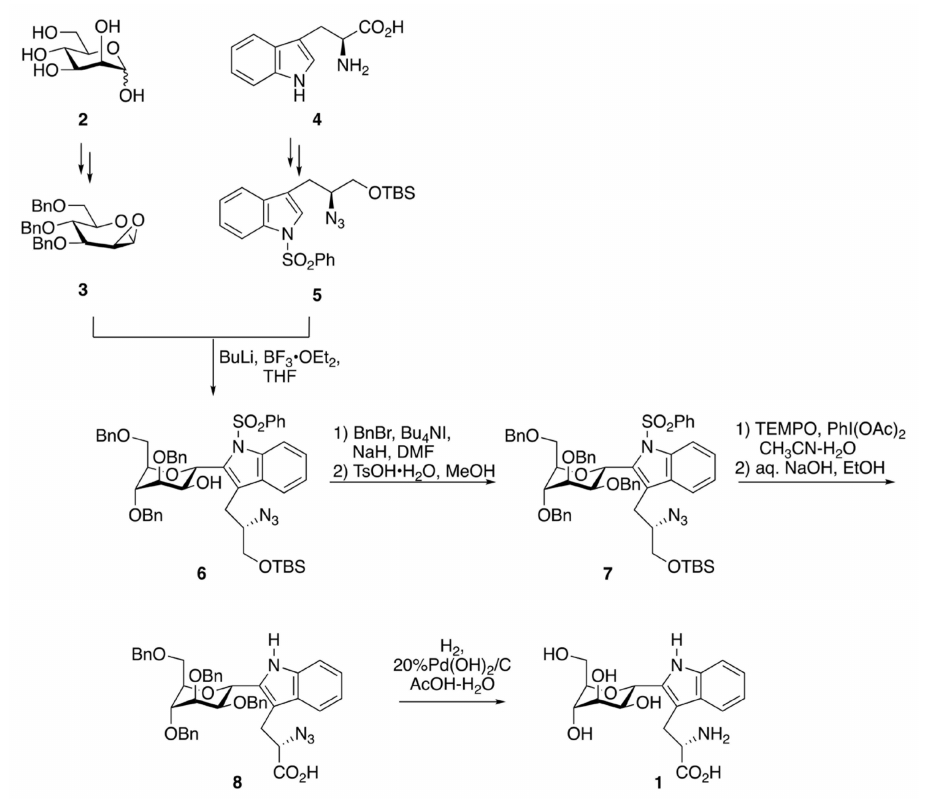
Scheme 1. Synthesis of C -Man-Trp by lithiated Trp to 1,2-anhydro mannose 3 .